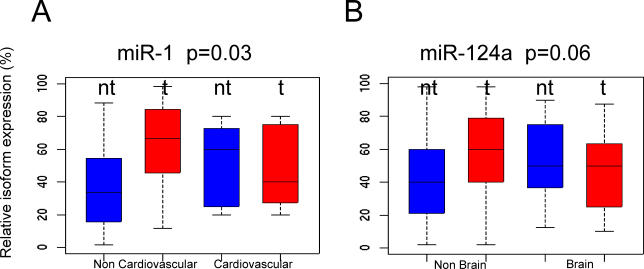
Relative EST-Based Expression of Isoforms Containing or Not Containing a Target for miR-1 or miR-124“t” indicates targeted forms, “nt” indicates nontargeted forms. The p-value on top of each panel is the significance of the expression reduction of targeted forms between the two tissue contexts.(A) For genes targeted by miR-1, relative expression was measured based on EST libraries flagged as cardiovascular in eVOC (right, “cardiovascular”), and all other libraries (left, “noncardiovascular”).(B) For genes targeted by miR-124, relative expression was measured based on all EST libraries flagged as brain in eVOC (right, “brain”), and all other libraries (left, “nonbrain”).